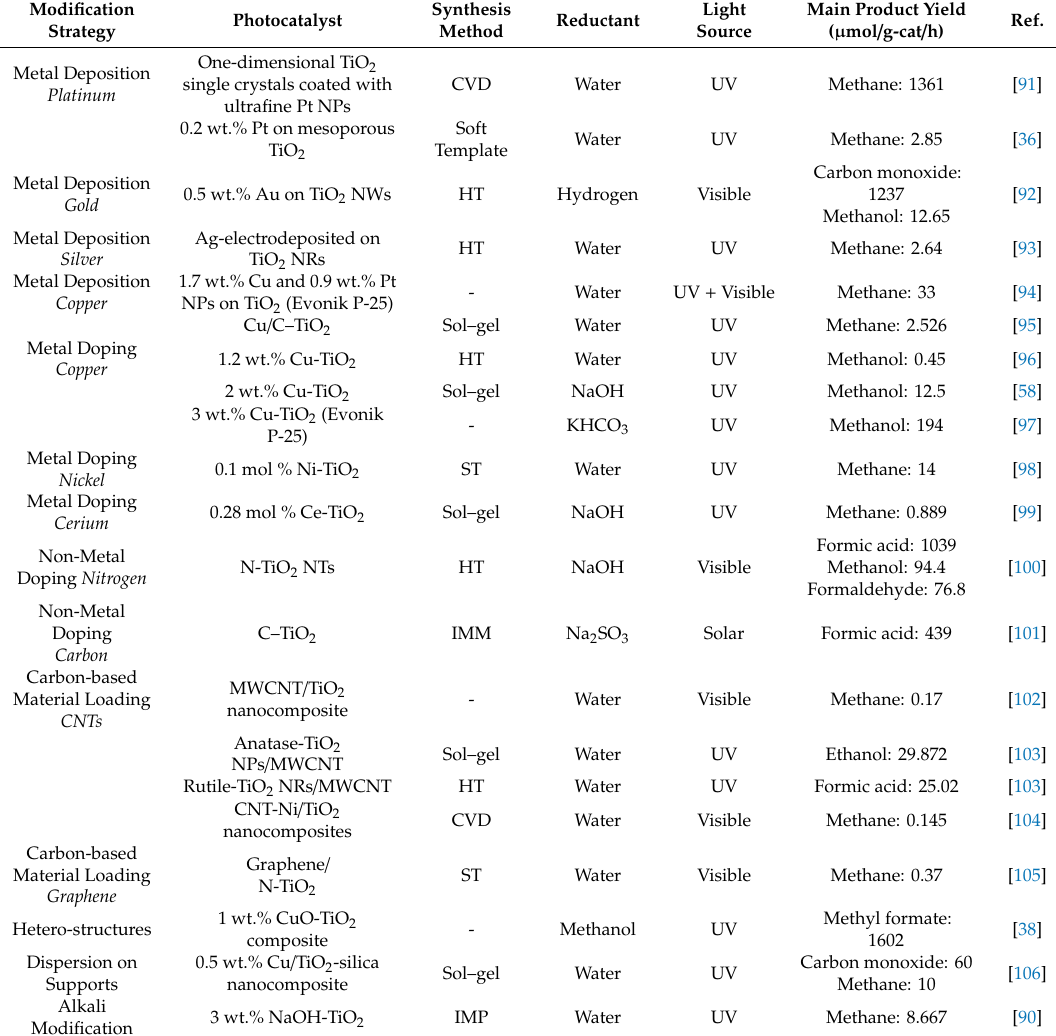
Table 2. Photocatalytic performance of various TiO 2 -based catalysts in the reduction of CO 2